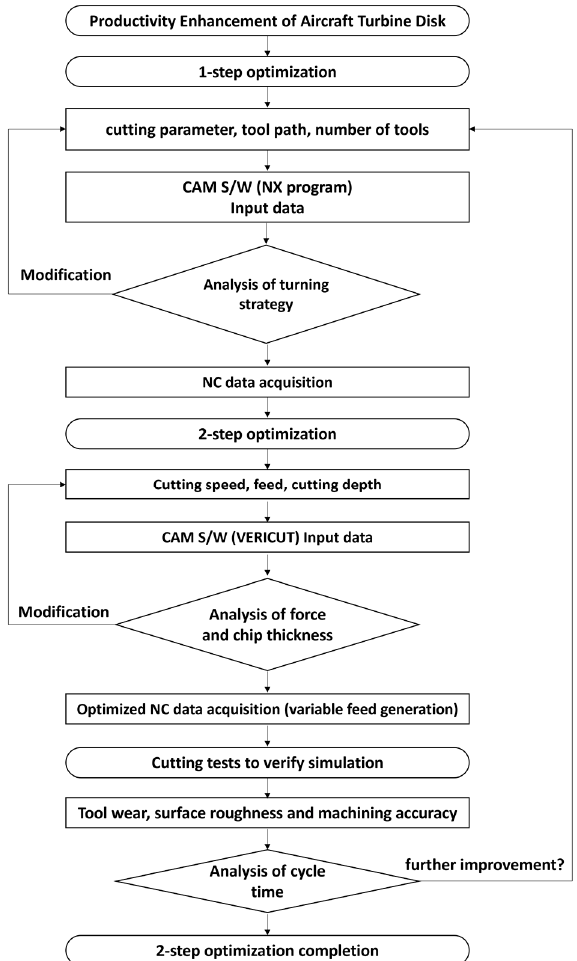
Figure 1. Flow chart of productivity enhancement of aircraft turbine disk using a two-step strategy.